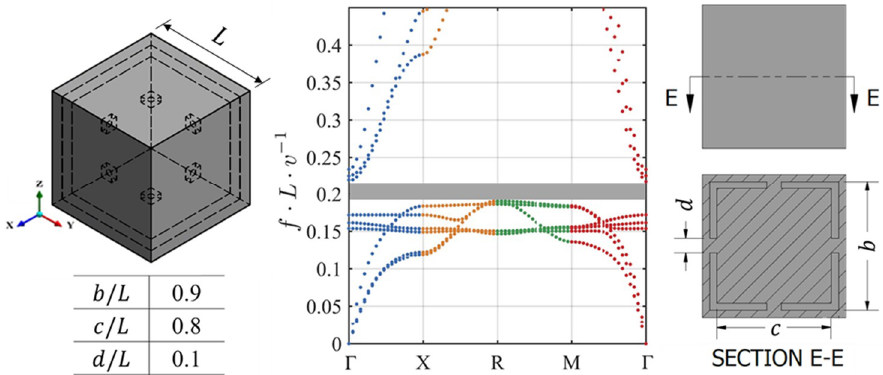
Figure 9. Multidimensional dispersion curves (DCs) of the lattice proposed by Wang et al. [25] as remodelled using our finite element (FE) modelling technique. The shaded grey area in the DC plot represents the identified bandgap (BG).